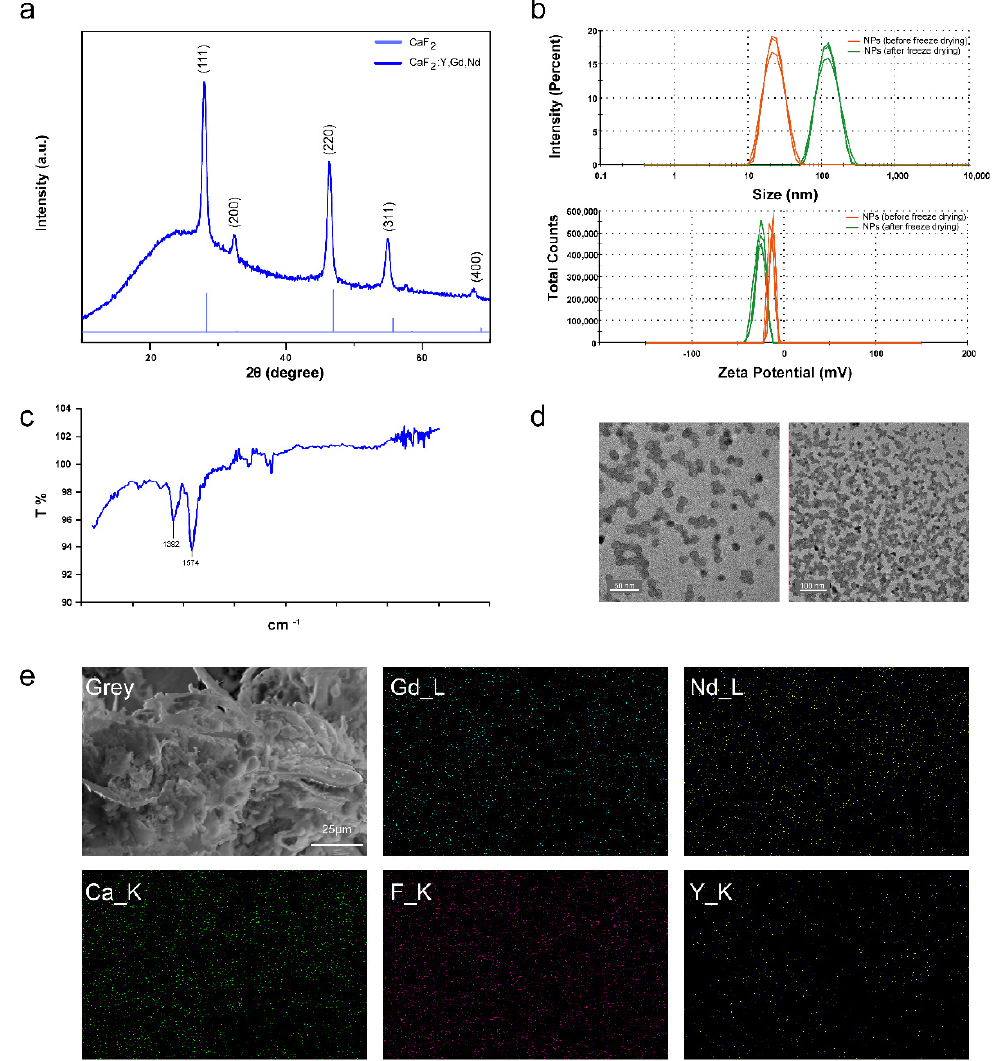
Figure 2. Morphology of CaF 2 :Y,Gd,Nd NPs. ( a ) XRD patterns of CaF 2 :Y,Gd,Nd NPs, and CaF 2 ; ( b ) DLS image of CaF 2 :Y,Gd,Nd NPs (1 mg/mL) before and after freeze drying. Measurements were repeated three times; ( c ) FTIR image of CaF 2 :Y,Gd,Nd NPs; ( d ) TEM images of water-soluble